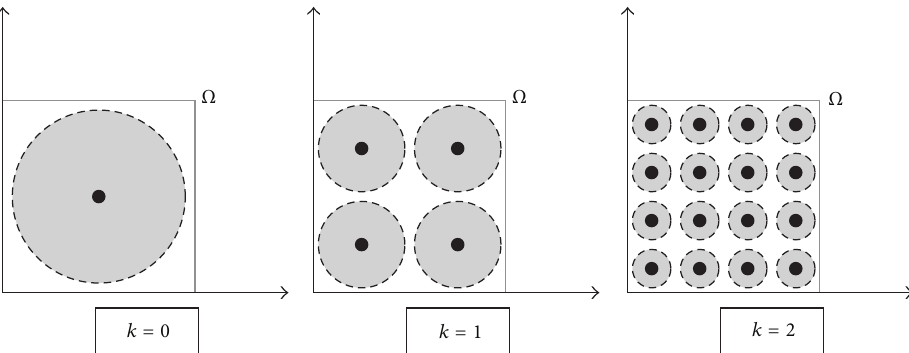
Figure 7: Discrete pedestrians (dots) and their continuous counterparts (circular regions delimited by dashed lines) in Ω = [0, 1] 2 ( 𝑑 = 2 ) and for 𝑘 = 0, 1,2